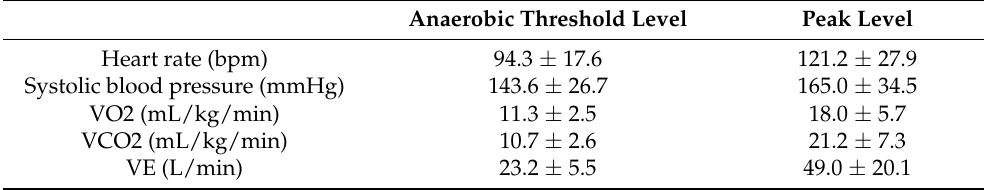
Table 2. Cardiopulmonary exercise